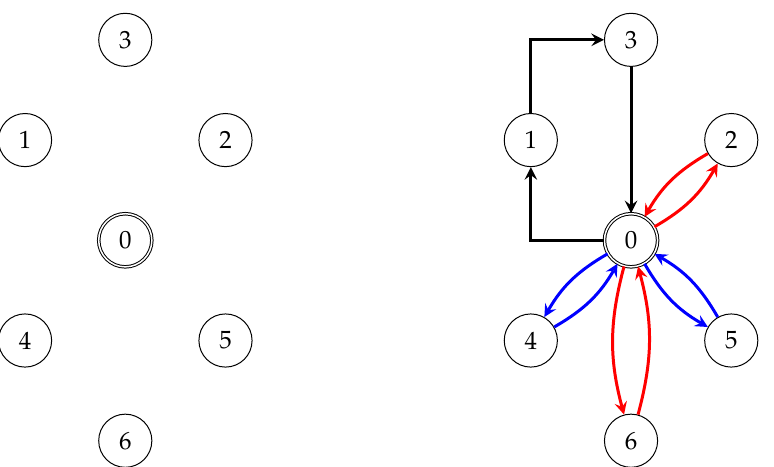
Figure 1. An example of PDSTSP is provided on the left; we assume that two drones are available (travel times are omitted for the sake of simplicity). A solution is provided on the right. The black arcs represent the tour of the truck that visits nodes 1 and 3 before going back to the depot. The red arcs depict the missions of the first drone (that serves nodes 2 and 6), while the blue arcs depict the missions of the first drone (that serves nodes 4 and